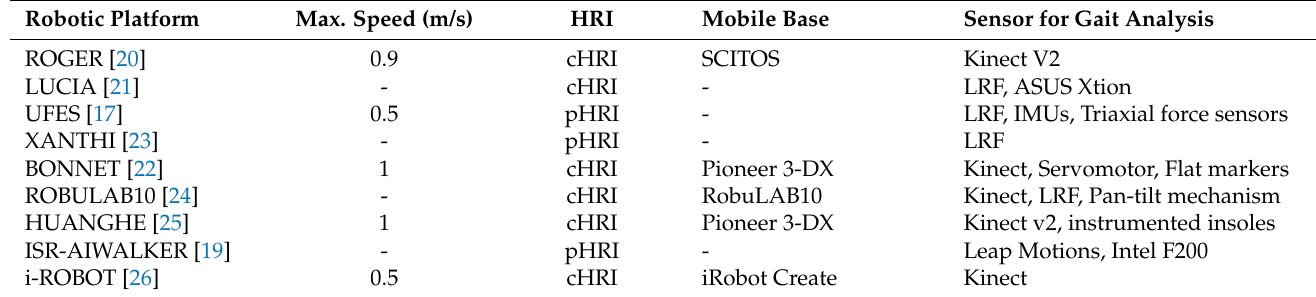
Table 1. Summary of robotic platforms for human gait